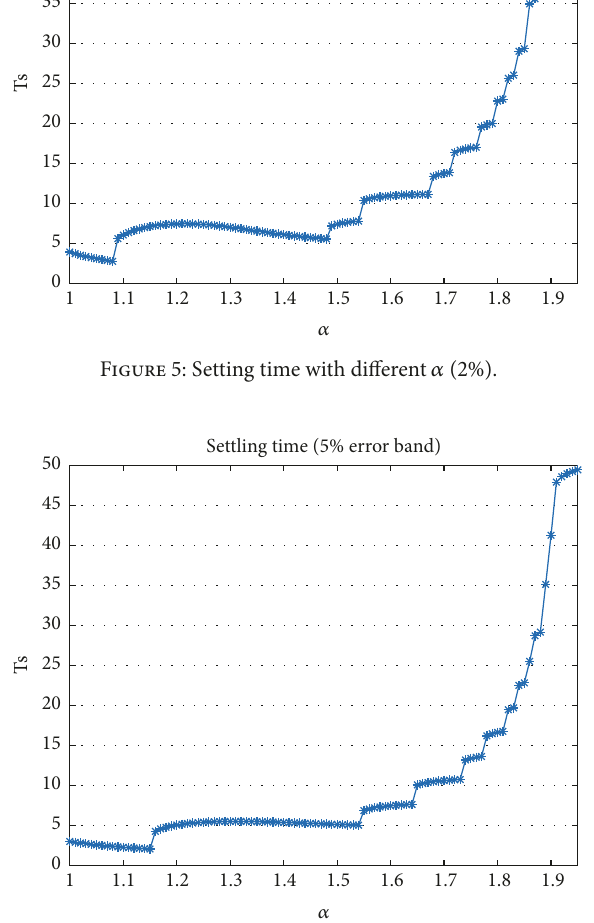
Figure 4: Rise time with different 𝛼 .